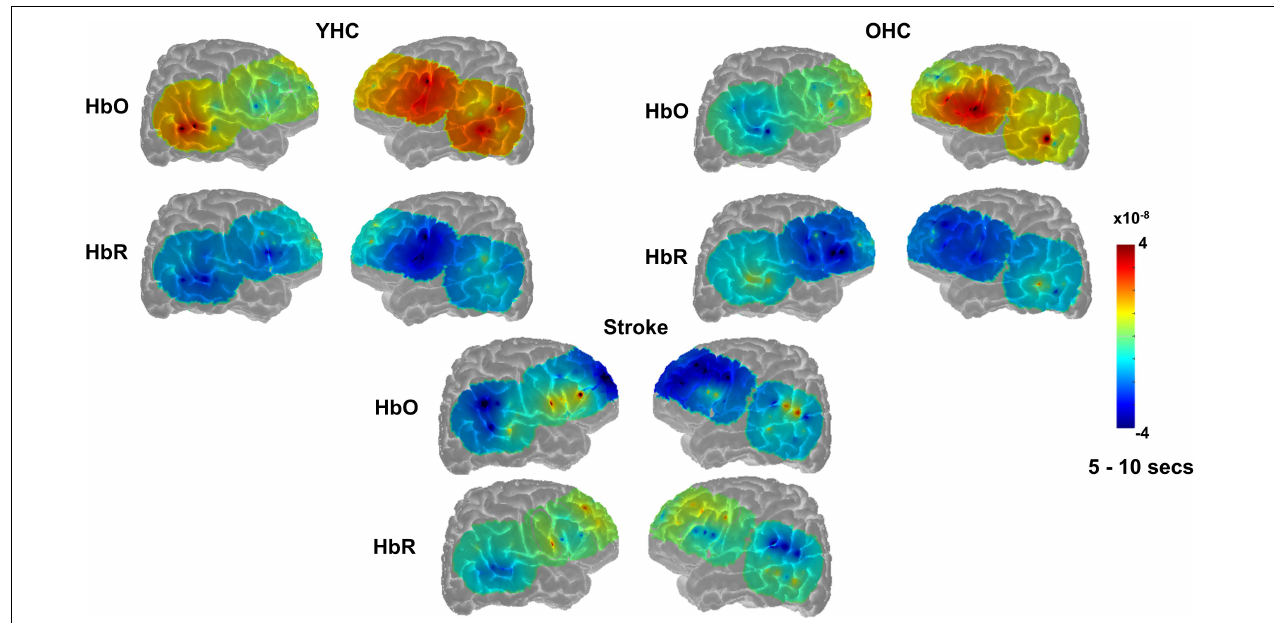
FIGURE 6 | Group mean HRF concentration overlays displaying the real minus scrambled picture contrast during semantic feature judgment. The color bar reflects the scale of the concentration change in µ M units. HbO, oxygenated hemoglobin concentration change; HbR, deoxygenated hemoglobin concentration change; YHC, younger healthy controls; OHC, older healthy